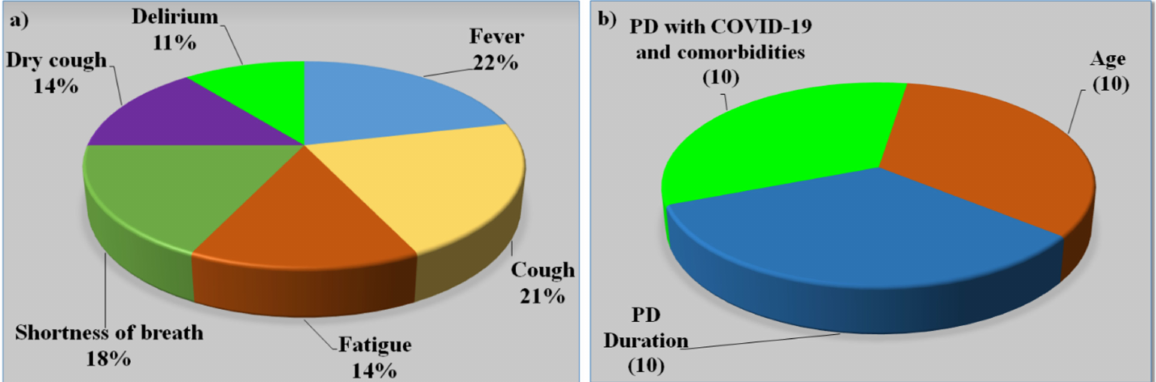
Figure 9. ( a ) The symptoms in patients with joint PD and COVID-19. ( b ) Risk Factors of PD and COVID-19 with